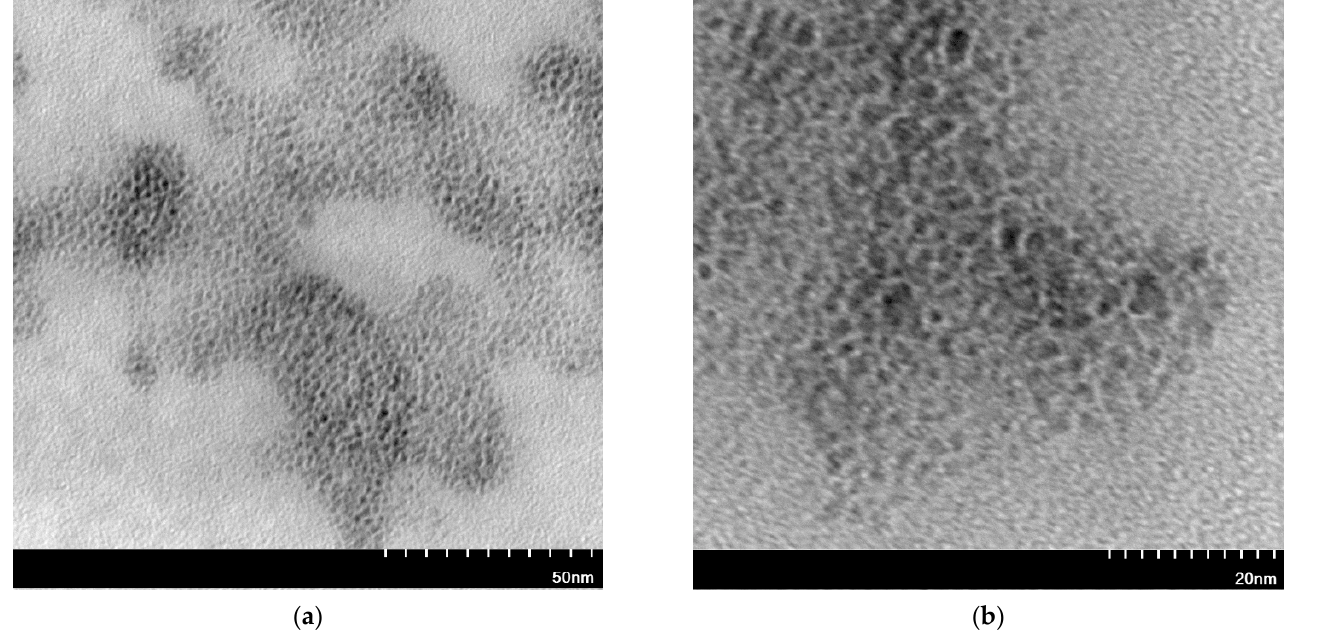
Figure A4. TEM images of Rh/Ru-NP (molar ratio of PGM:PVP:reducer was 1:5:2) using ( a ) AA and ( b ) NaBH 4 .